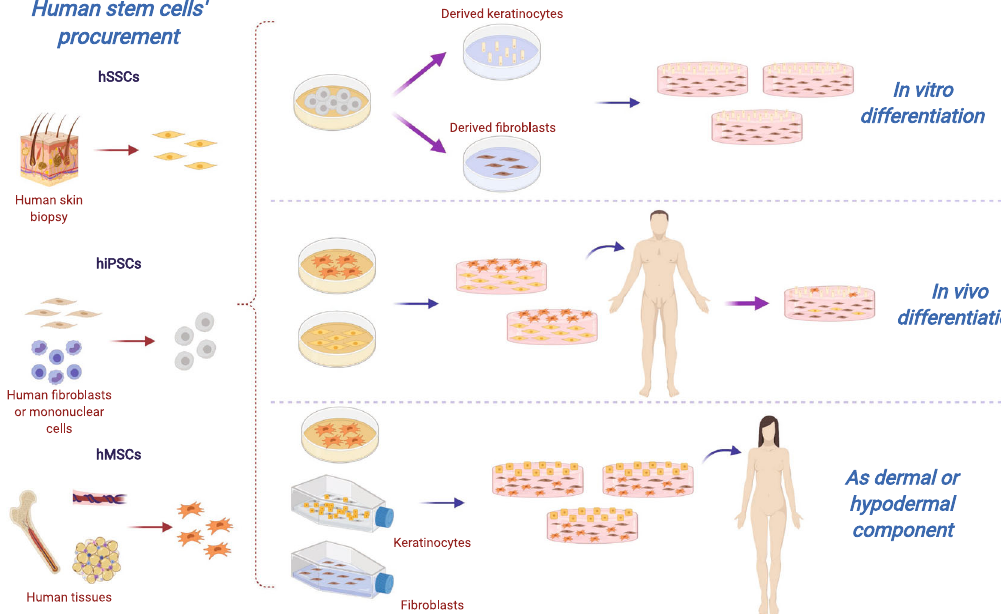
Fig. 3 Human stem cells ’ (hSCs) strategies for tissue-engineered skin substitutes (TESSs). Different sources of hSCs could be (i) differentiated in vitro to the main cutaneous lineages and then, uses to fabricate arti fi cial skin; (ii) embedded directly into dermal scaffolds and engrafted to achieve an in vivo differentiation; or (iii) combined with human keratinocytes and fi broblasts to bene fi t from their own angiogenic and immunomodulatory properties. hSSCs human skin stem cell, hiPSCs human-induced pluripotent stem cells, hMSCs human mesenchymal stem cells. Created with